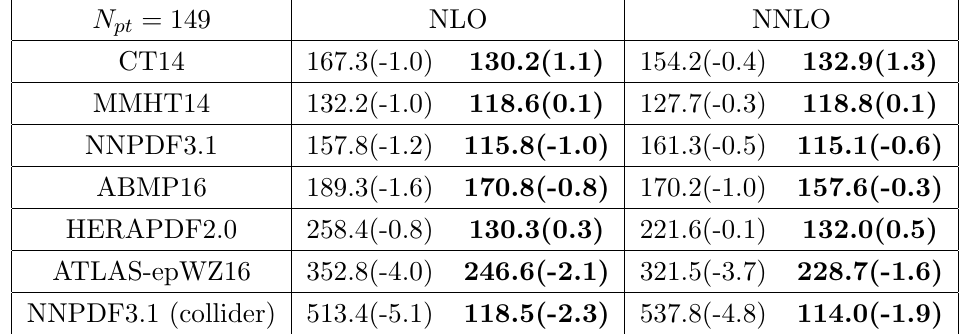
p = 1 : 3 GeV and (cid:22) = . The Q 2 + m 2 c c